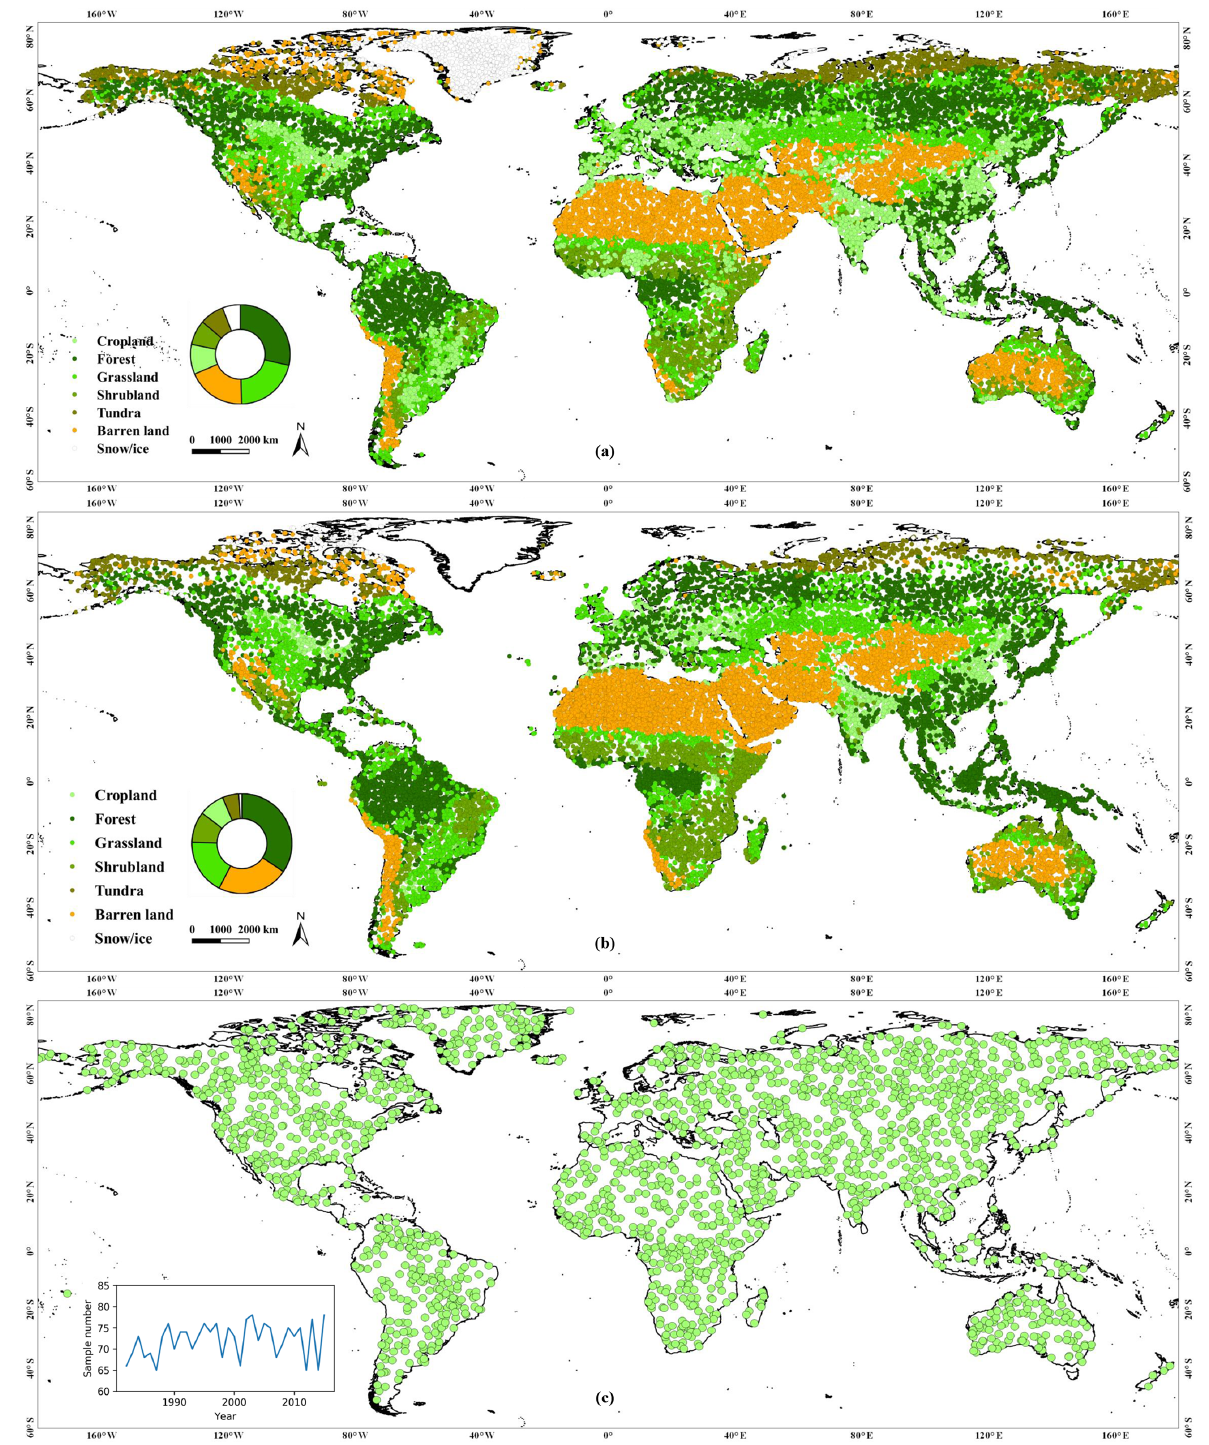
Figure 2. The geographical distribution training sample and test sample. (a) Training sample in 2015, where different colors represent the different classes. (b) Huge homogeneous test samples (H-homo sample) in 2015, where the different colors represent the source of the sample units, either FROM-GLC_v2 or FLUXNET. (c) Independent test sample in different years, where the temporal distribution is shown in the inner